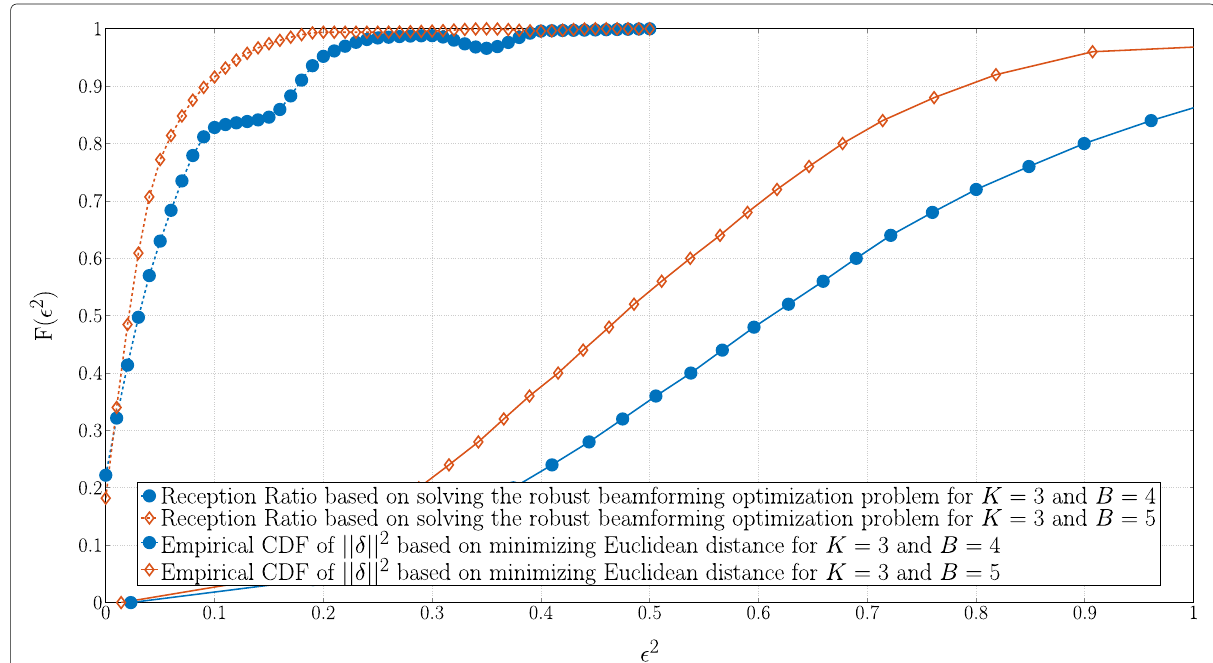
in higher values of optimal B ∗ . The upper bound used nodes for cooperation on energy efficiency. The simula- tion results showed that energy efficiency can be further